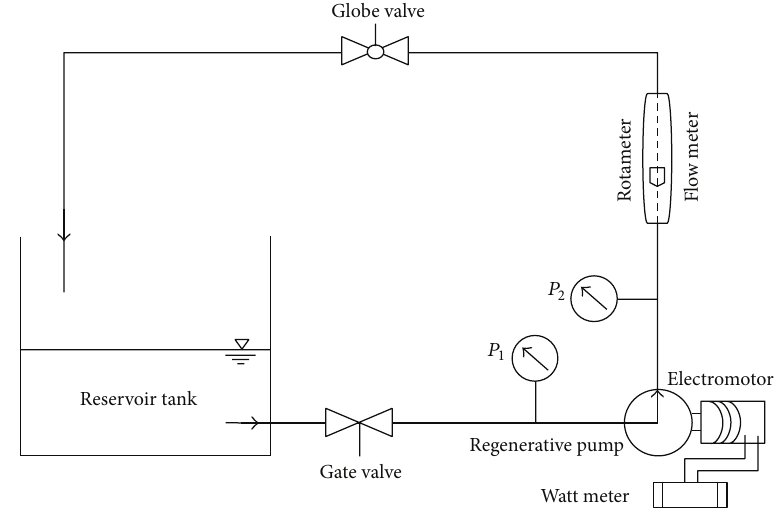
Figure 3: Schematic of regenerative pump test rig.